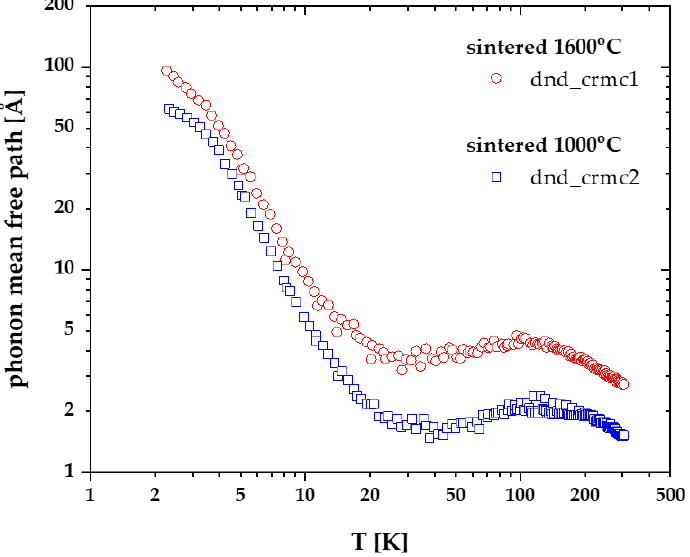
Figure 9. Phonon mean free path in differently sintered nanodiamond ceramics as a function of temperature.